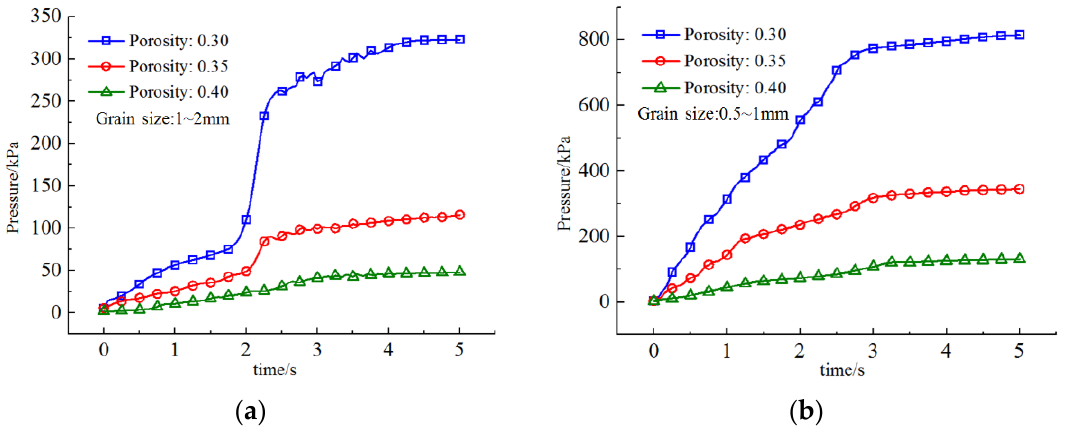
Figure 6. ( a ) shows injection pressure versus grouting time with 1~2 mm grain sizes and different porosity. ( b ) shows injection pressure versus grouting time with 0.5~1 mm grain sizes and different porosity.